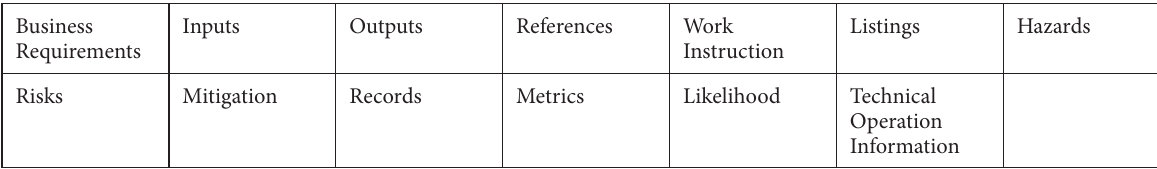
Table 5. Textual description of process flow chart Business